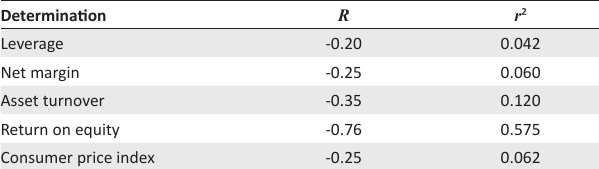
TABLE 12: Summary of correlation and coefficient of